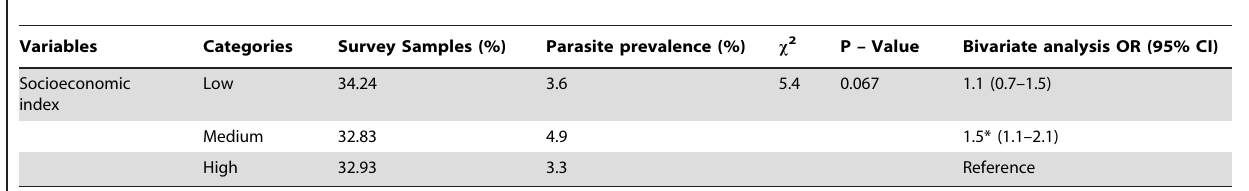
Table 5. Microfilaria prevalence according to socioeconomic index (developed using all socioeconomic variables) in Karimnagar district of Andhra